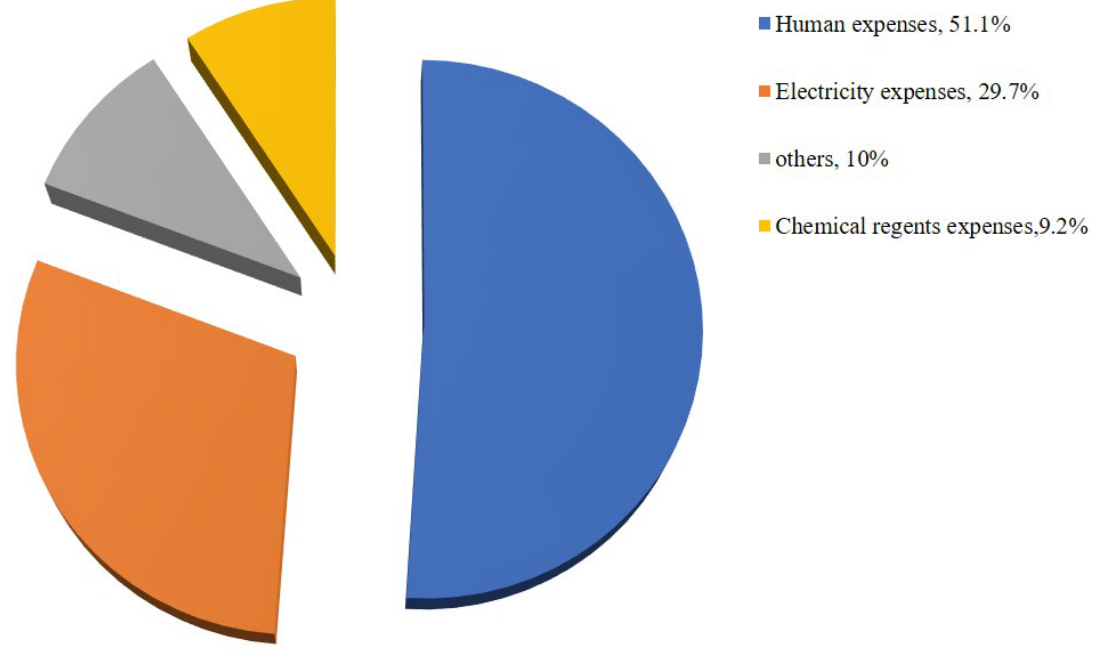
Figure 6. Daily running cost during steady running period (treatment capacity of 1500 m 3